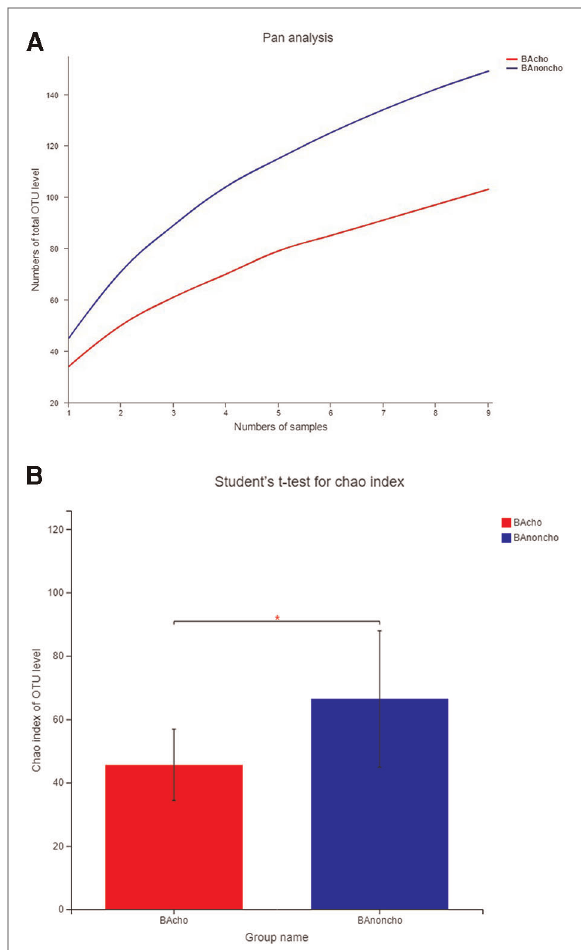
FIGURE 1 The OUT level in BAcho and BAnoncho. ( A ) The numbers of total OTU level were increasing with the numbers of samples. The numbers of OTU level in BAnoncho were more than those in BAcho in same numbers of samples. ( B ) In BAnoncho group, Chao index of OTU level was signi fi cantly increased compared to the BAcho group. (* p <0.05, OTU: Operational Taxonomic Unit, de fi ned by >97% 16S rRNA sequence similarity. Chao index:using for calculating the Community